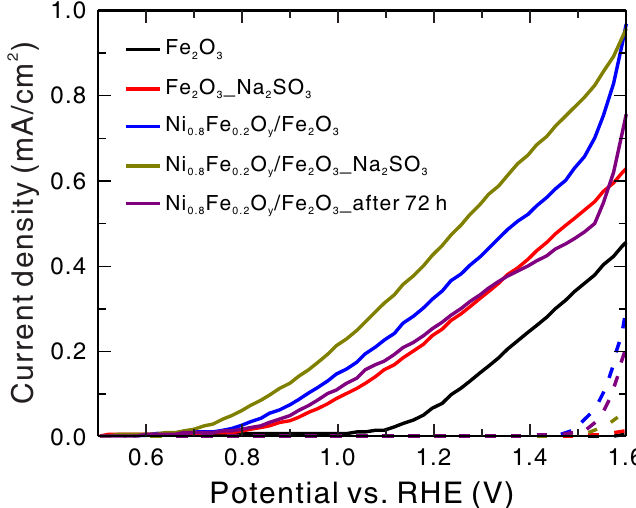
Figure 8. J–V curves of the Ni 0.8 Fe 0.2 O y /hematite photoanode and the bare hematite photoanode measured at the light-on and light-off conditions with and without the presence of 0.1 M Na 2 SO 3 as the hole scavenger (sacrificial reagent) in the electrolyte. To reveal the stability, the J–V curve of the same Ni 0.8 Fe 0.2 O y /hematite photoanode measured after 72 h continuous light-on operation at 1.23 V vs. reversible hydrogen electrode (RHE) is also shown for